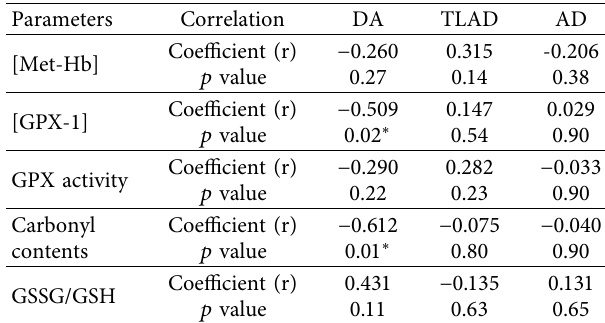
Figure 5: Correlation analysis of protein carbonyl contents and GSSG/GSH ratio in red cell lysates from study subjects. A sig- nificant, linear, and direct relationship was demonstrated with r � 0.429, p � 0 . 01. The solid line defines the best fit line for the correlation model while the dotted lines define the standard error means (SEM). Table 2: Correlation analysis of studied serum redox markers and addiction profile data of chronic heroin addiction subjects. A significant correlation was evident for [GPX-1] and carbonyl contents with the duration of addiction ( p < 0 .